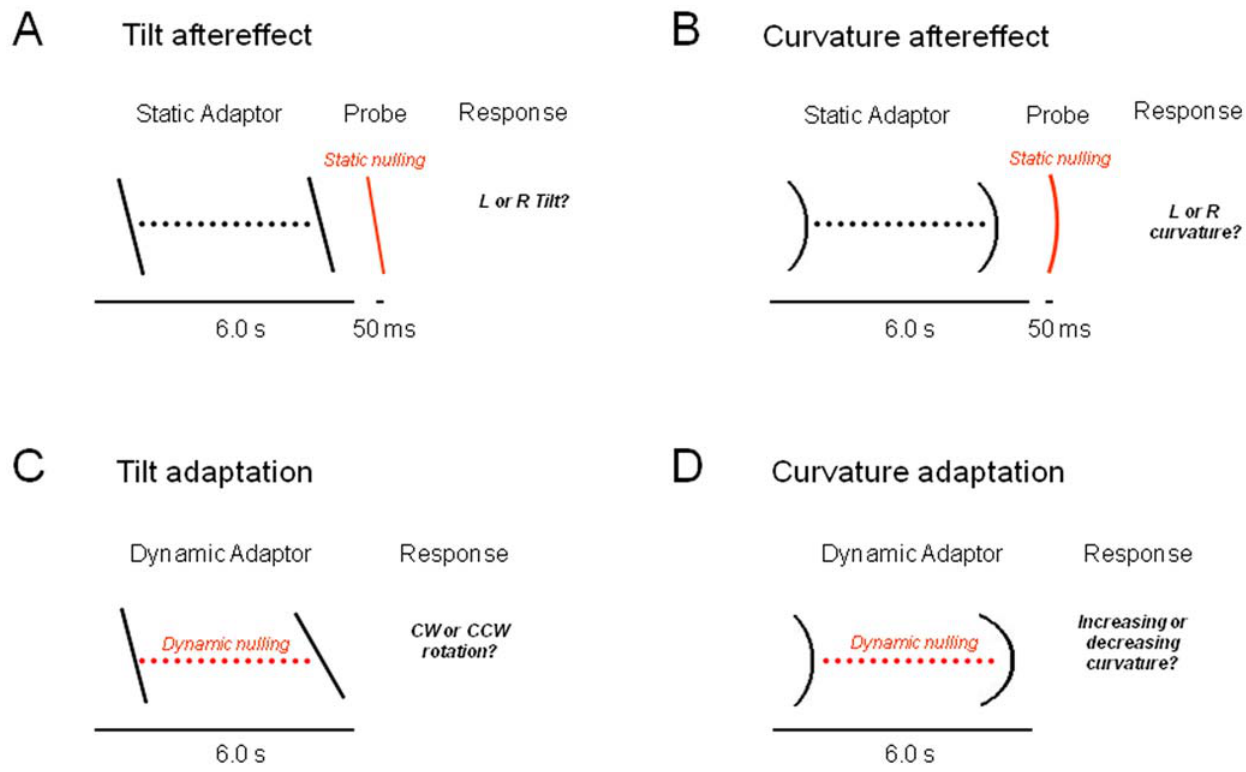
Figure 2. Experimental Design. The stimuli consisted of an array of 11 white dots on a black background. As subjects fixated on the center dot, a nulling procedure was implemented by means of a forced choice paradigm and an interleaved staircase procedure (see Materials and Methods ). A. The tilt aftereffect was measured for 12 adaptation orientations evenly spaced from 2 90 u to + 90 u , with the probe’s nulling orientation changing by increments of .25 u during the staircase. Subjects reported whether the probe stimulus was tilted clockwise or counterclockwise. B. The curvature aftereffect paradigm was similar, with the increments of .5% changes in aspect ratio (defining the curvature) during the staircase. Subjects reported whether the probe stimulus appeared more leftward or rightward. C. Changes in perceived orientation during prolonged adaptation were assessed using the dynamic nulling paradigm. The stimulus was slowly rotated during adaptation, with subjects required to report when it was stationary. Increments in the physical rate of rotation during the staircase procedure were in steps of .0625 u /s. D. Dynamic nulling of the curved line was similar, with subjects asked whether the observed curve was curling more leftward or rightward. Increments in the rate of curling motion aspect ratio were .1%/s.